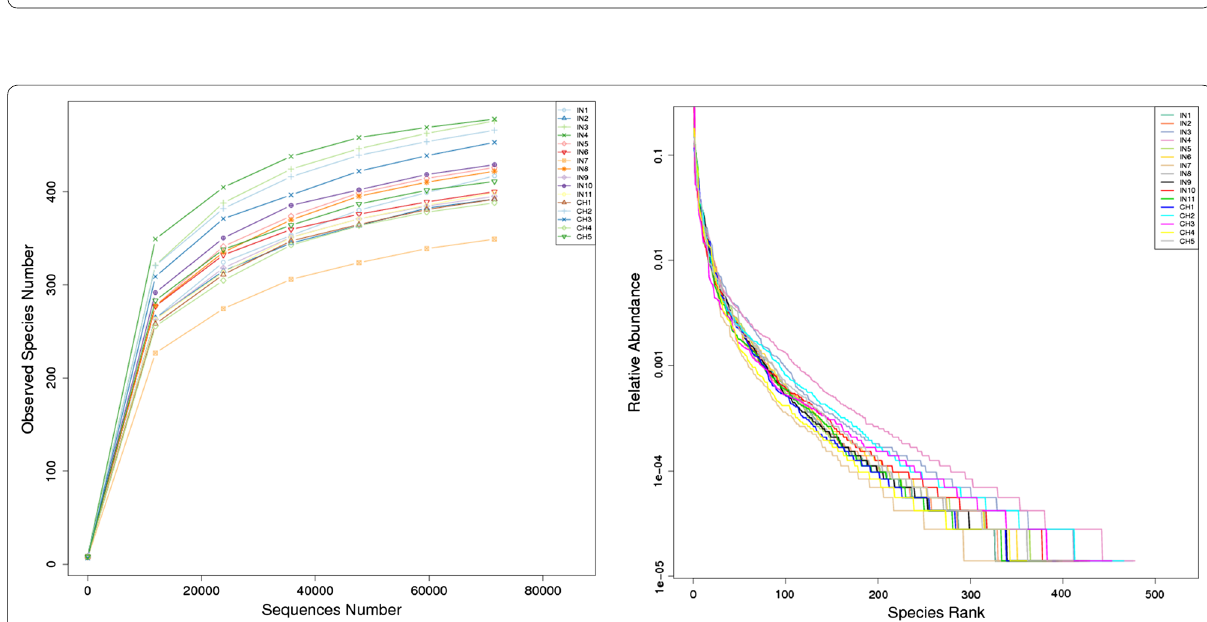
Fig. 3 Subjects are clustered based on their dietary habits. a Partial least square discriminant analysis of gut bacterial profiles of Indian and Chinese adults. b Relative abundance heat map of top 35 genera